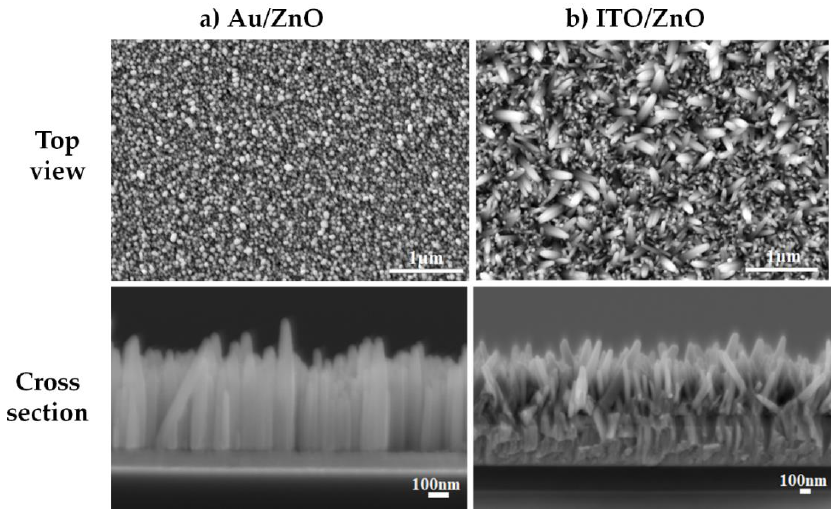
Figure 7. Top and cross-sectional views of SEM micrographs of ZnO NWs deposited on ( a ) Au/ZnO and ( b ) ITO/ZnO seed layer structures. Table 2. Morphological characteristics of ZnO NWs deposited on Au/ZnO and ITO/ZnO seed layer structures.